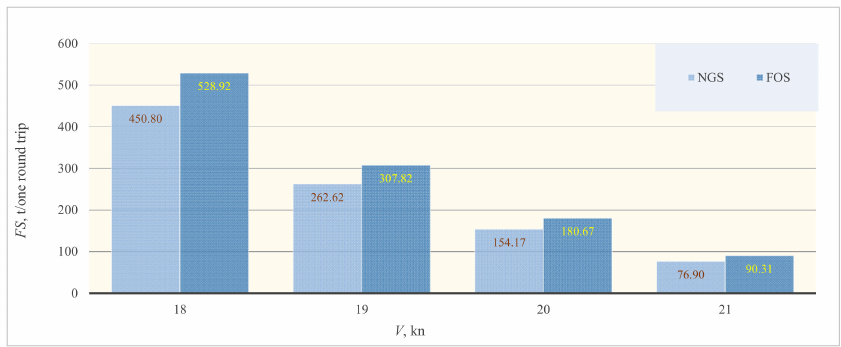
Figure 23. The fuel savings per one round trip for navigation under